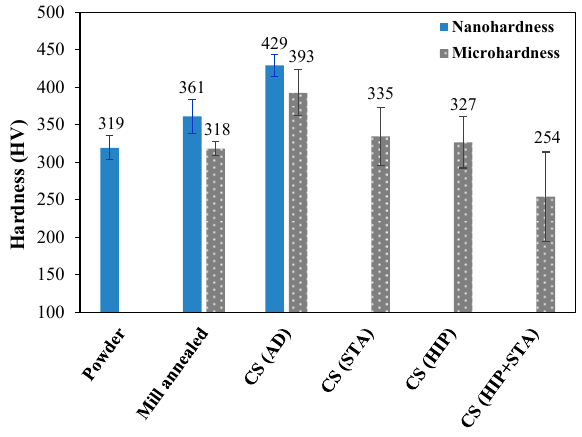
Figure 3. Comparison of average hardness values among CS Ti6Al4V deposits in various conditions (as-deposited and after thermal treatments), feedstock powder, and mill annealed Ti6Al4V substrate. A decrease in hardness was observed as a result of various thermal treatments. After